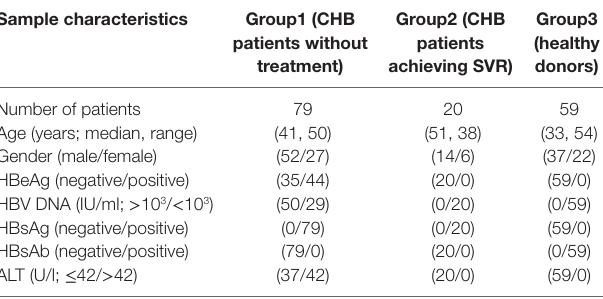
TaBle 1 | Clinical characteristics of human